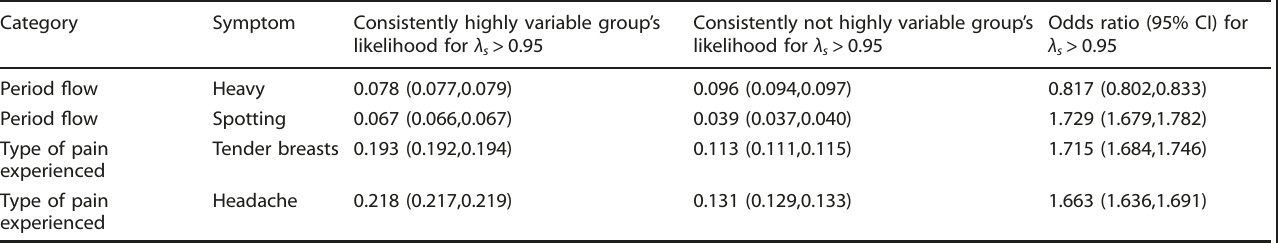
Table 6. Pain and period tracking odds ratios for high extreme end of the proportion range.